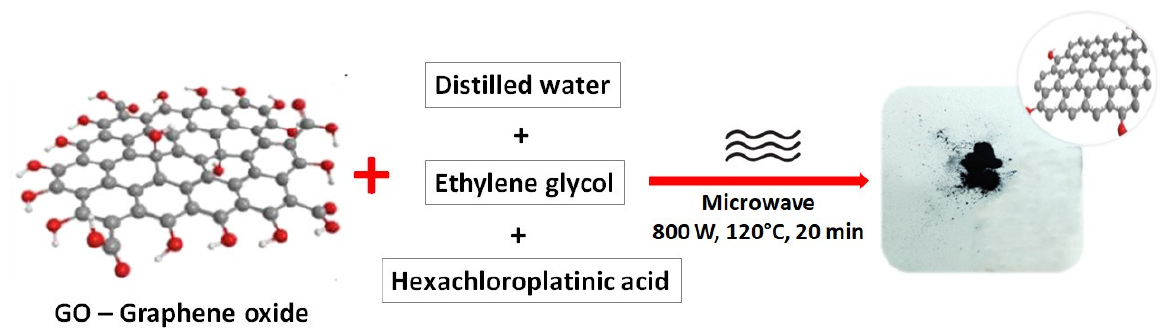
Figure 1. Summarized scheme of the PtrGO powder synthesis using the microwave method.